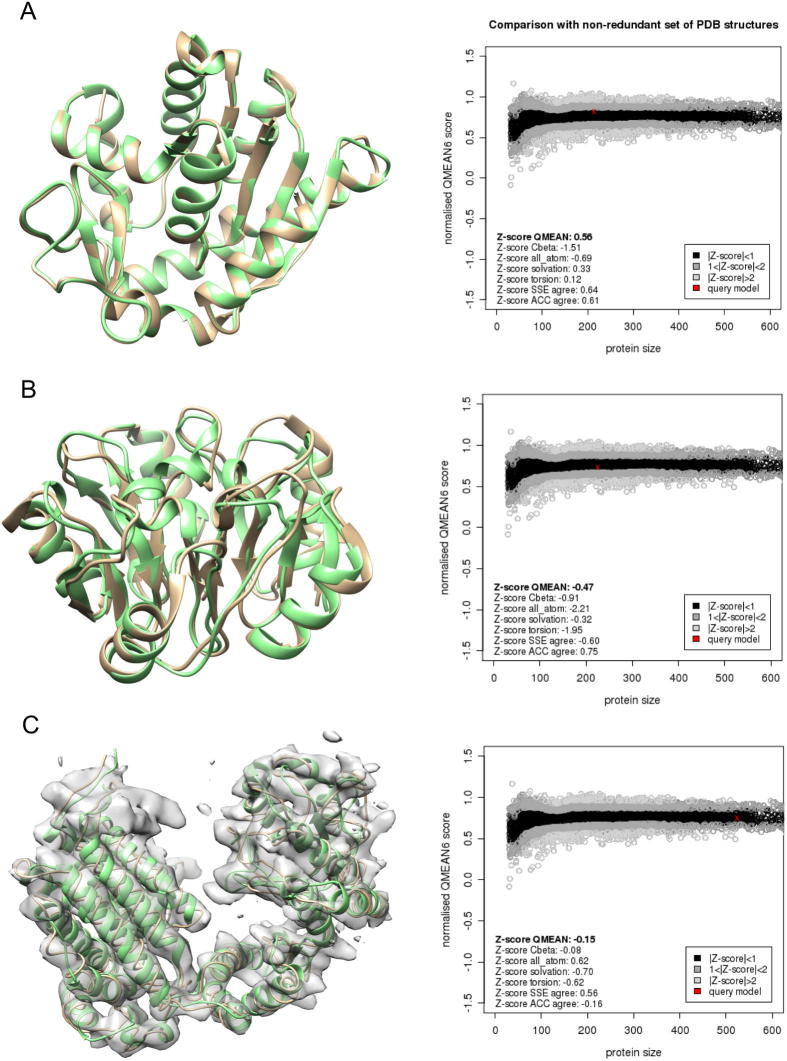
(A) Refinement of a homology model of E. coli adenylate kinase homology model into a 2.5 Å map representing inhibitor bound form (1AKE). Left: comparison of the refined model (green) with the X-ray structure (light-brown). Right: Qmean analysis (http://swissmodel.expasy.org/qmean/cgi/index.cgi) of the refined model showing the agreement with high quality structure in PDB. (B) refinement of a homology model of Initiation factor 6 (eIF6) into a 3.3 Å resolution map of 60S ribosome from D. discoideum bound to eIF6 (EMD-3145). Left: comparison of refined model (green) with the X-ray structure (light-brown). Right: Qmean analysis of the refined model showing the agreement with high quality structure in PDB. (C) Flexible fitting of ADP-bound GroEL (PDB: 4KI8) to the density corresponding to the unliganded form solved at 4.2 Å resolution (EMD-5001). Left: comparison of the refined model (green) with the X-ray structure (light-brown). Right: Qmean analysis of the refined model showing the agreement with high quality structure in PDB.